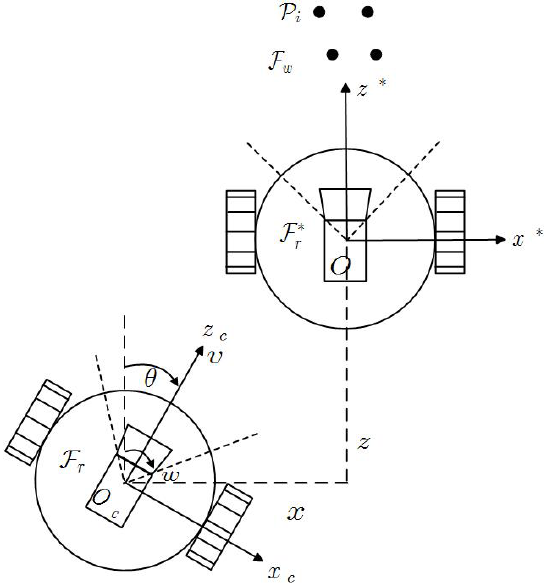
Figure 1. Coordinate relationship for a mobile robot with a limited field-of-view (dashed lines)